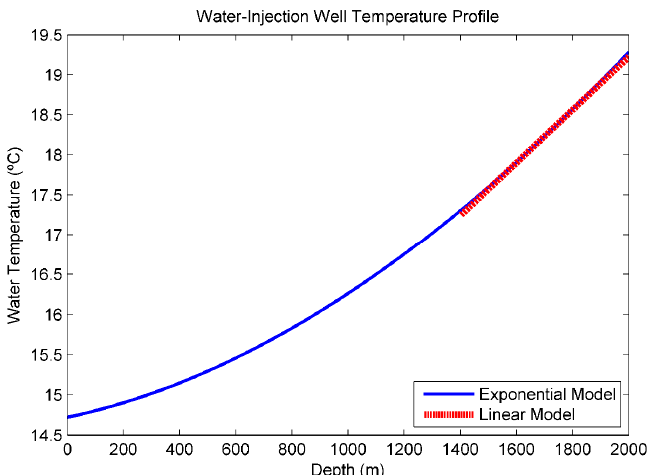
Figure 4. Theoretical Water-Injection Well Fluid Temperature Profile. The blue line represents the exponential Ramey model. The red dots represent the linear approximation. In this example [5], it is assumed to be a single-zone water-injection well with the following characteristics; injection rate: 4790 bbl/d (8.80 m³/s); surface water temperature: 58.5 °F (14.7 °C); no tubing; inside diameter of casing: 6.366 in (0.16 m); geothermal gradient: 0.0083 °F/ft (0.0151 °C/m); geothermal temperature at surface: 70.0 °F (21.11 °C).